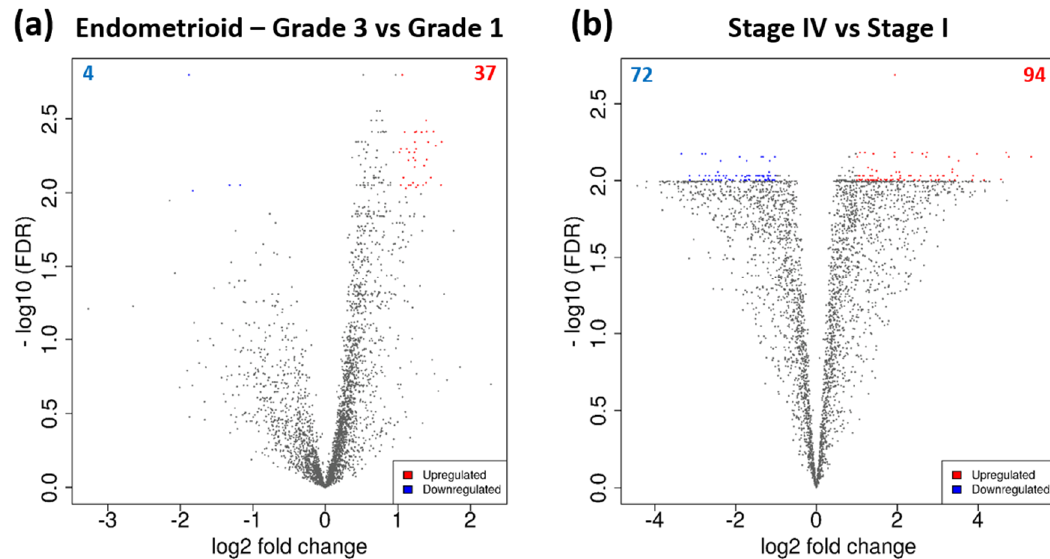
Figure 5. DEGs associated with tumour grade and clinical stage. Volcano plots of DEGs between ( a ) grade 1 and grade 3 endometrioid, and ( b ) stage I and IV EC. Significant DEGs are coloured; red dots represent upregulated genes, and blue dots represent downregulated genes. Cut-off criteria: │ log2FC > 1 │ and FDR < 0.01.